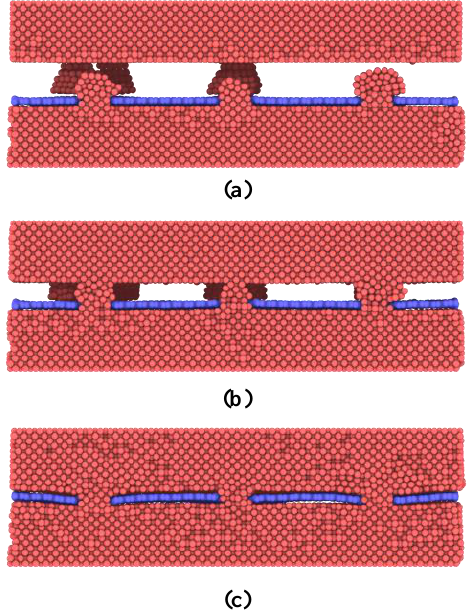
Figure 3. Cross-section configurations of Cu-nanoporous graphene-Cu during the bonding process at various stages. ( a ) Contacting of bonding surface; ( b ) Compression deformation of the nanoislands; ( c ) Final bonding